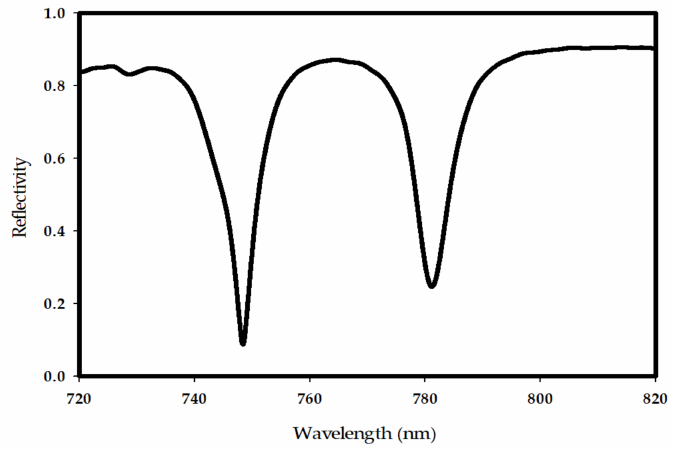
Figure 4. Reflectivity of the 2D-PhC